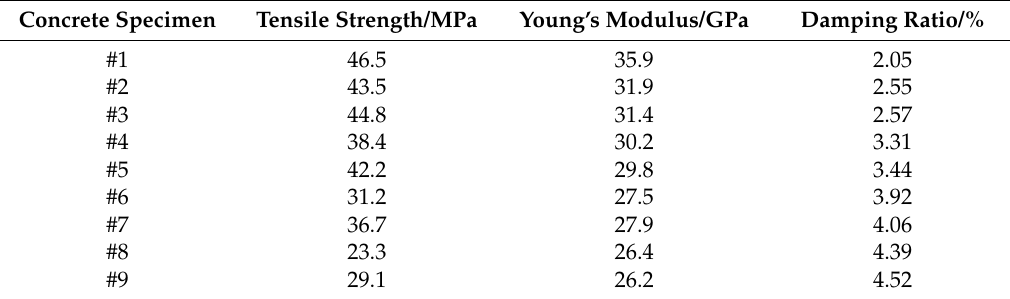
Table 2. Test results for high damping concretes.